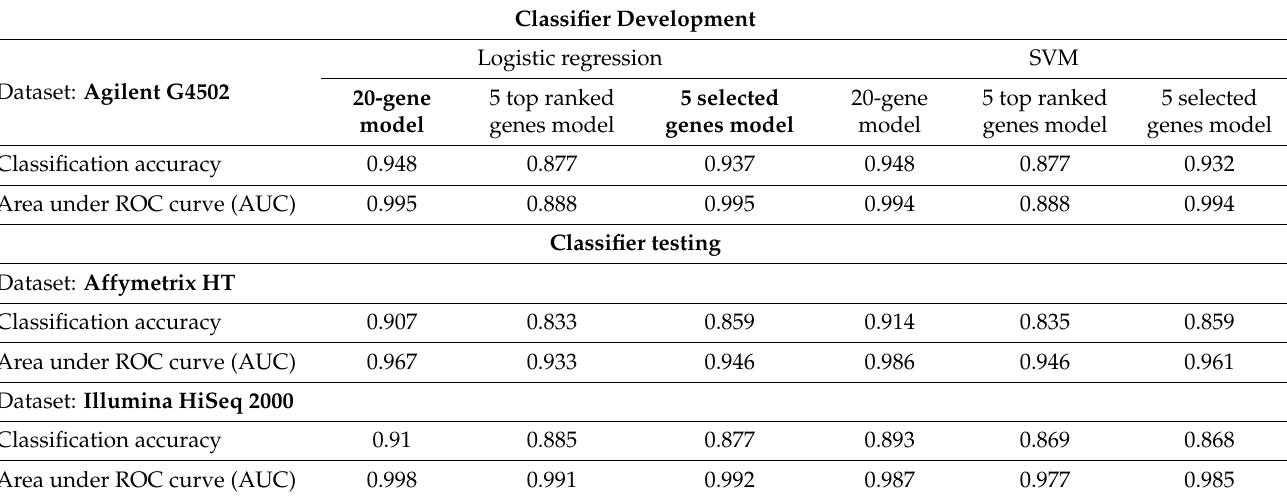
Table 1. The comparison of different models’ performance during the construction of the classifiers and testing